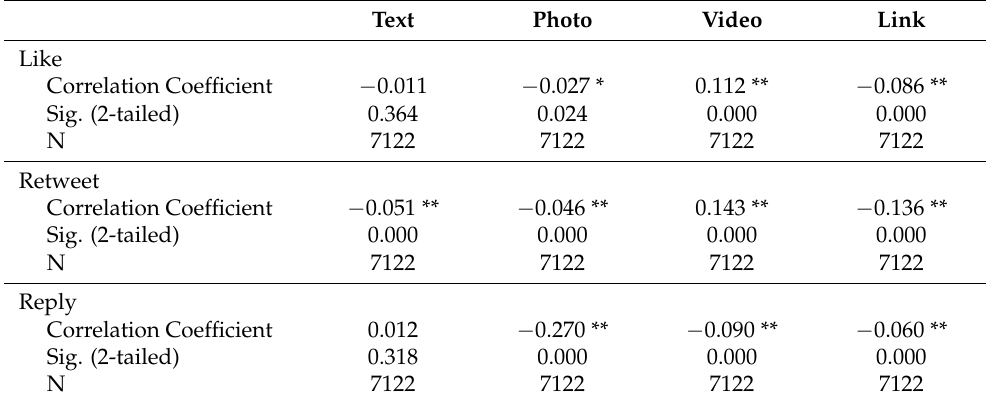
Table 2. Post type correlation